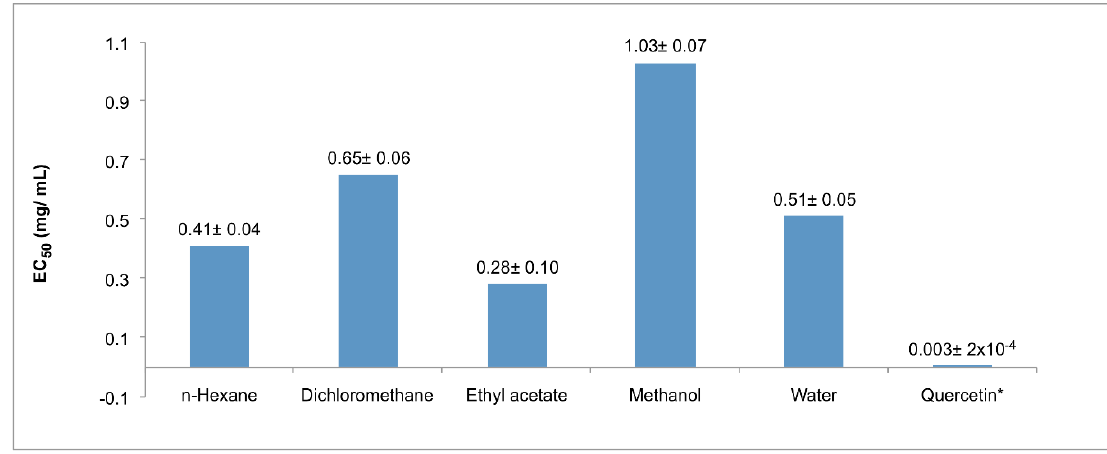
Figure 1. β -carotene-linoleic acid assay of extracts from aerial parts of Salvia pachyphylla . * Used as a reference compound. Values are mean ± SD, n = 3.